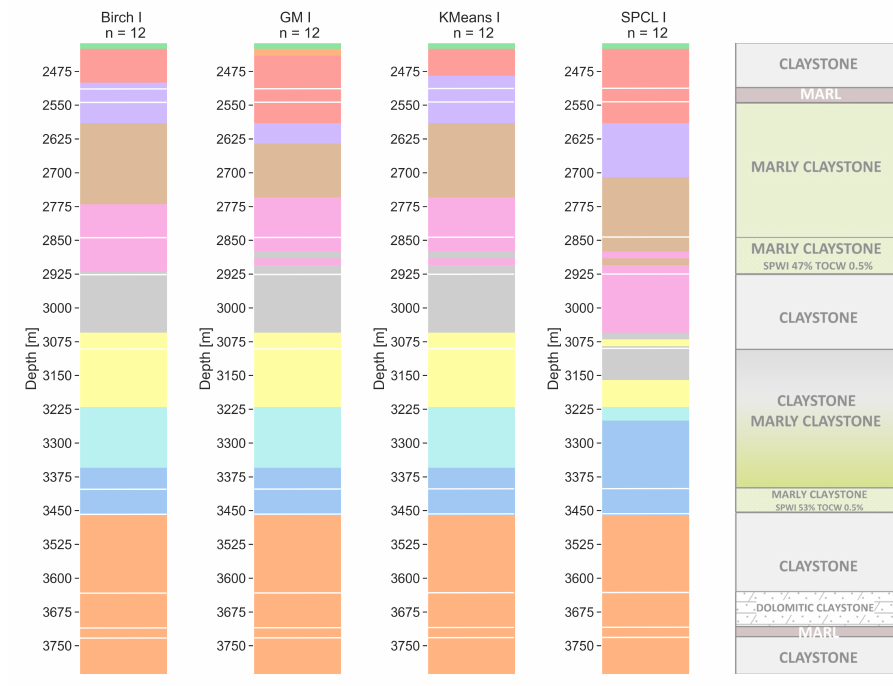
Figure 10. Walkaway VSP resolution clustering models for a number of clusters equal to 12 with lithology from well core (with lines). Clustering methods: BIRCH—balanced iterative reducing and clustering using hierarchies, GM—Gaussian mixture model, k-means, and SPCL—spectral clustering.